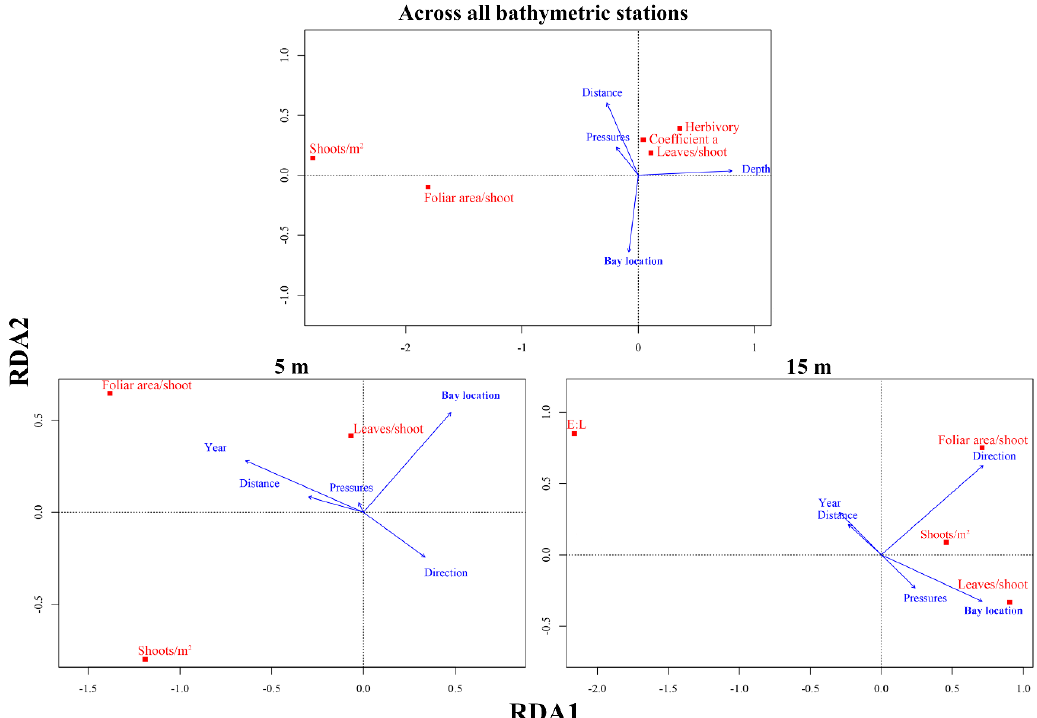
Figure 7. Redundancy (ordination) analysis ( RDA) between the P. oceanica descriptors and proxies of anthropogenic pressures, depth, and time across the whole Vasiliko bay ( top panel ), shallow 5 m depth ( bottom left ) and intermediate 15 m depth ( bottom right ). The model with all the terms together was significant across all bathymetric stations (df = 4, Variance = 1.12, F = 35.25, p < 0.001), 5 m (df = 5, Variance = 0.60, F = 9.73, p < 0.001) and 15 m (df = 5, Variance = 0.60, F = 18.90, p < 0.001).